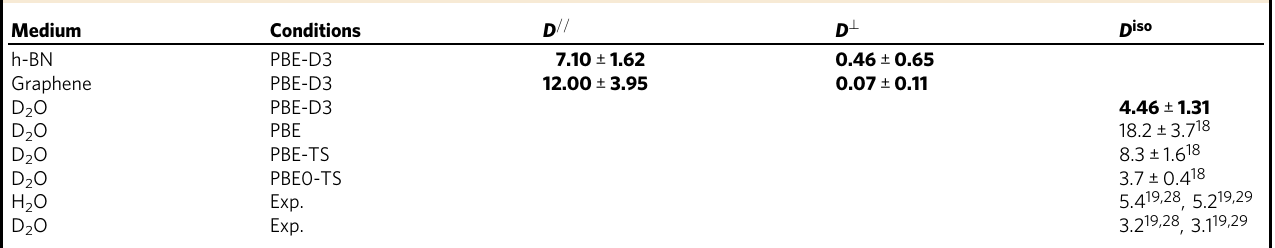
D == and D ? respectivelycorrespondtolateralandverticaldiffusionwithrespecttothesurface,while D iso referstoisodirectionaldiffusion.Valuesobtainedinthepresentworkarewritteninboldfontand the corresponding errors (standard deviations) were estimated by block analysis of linear regressions over mean square displacements of the